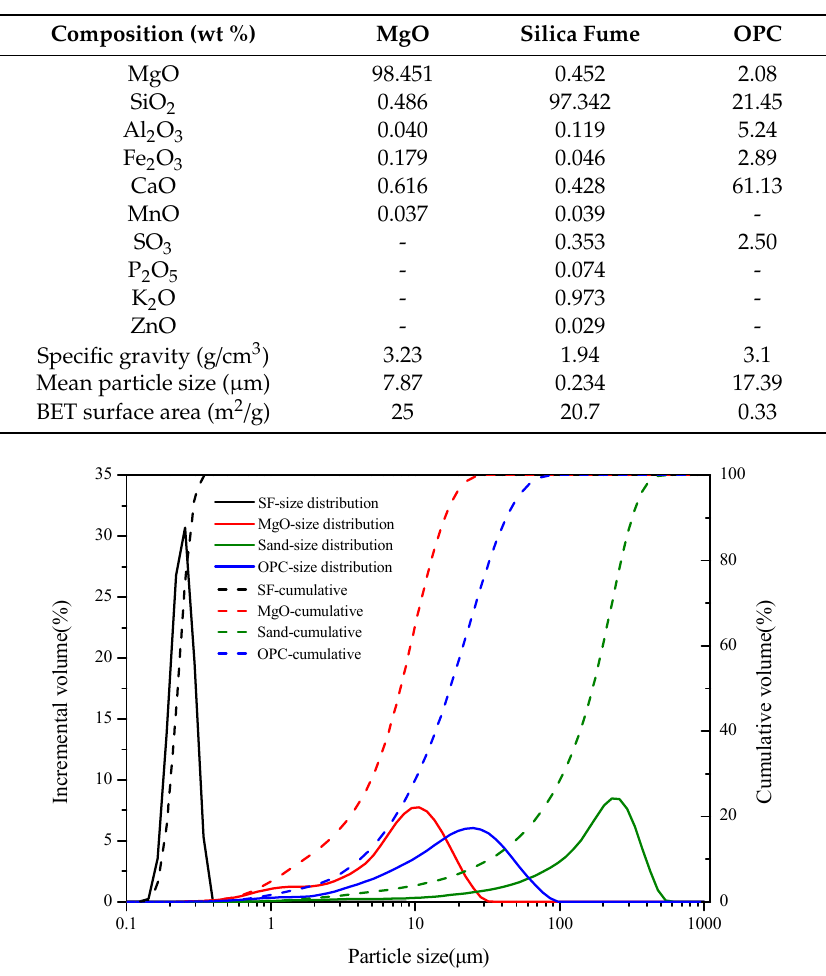
Figure 1. Particle size distribution of the main raw materials.